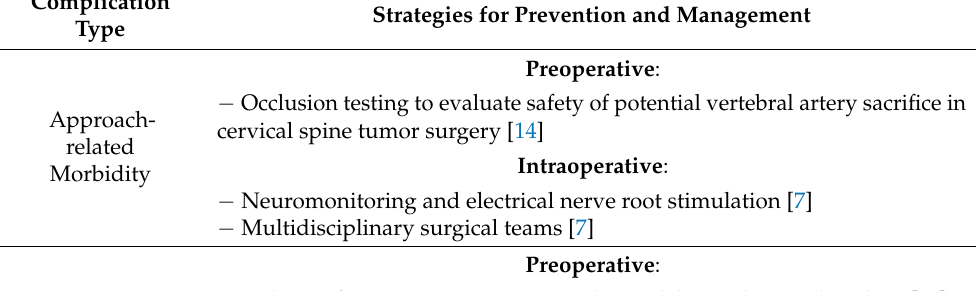
Table 2. Strategies for complication avoidance in spine tumor